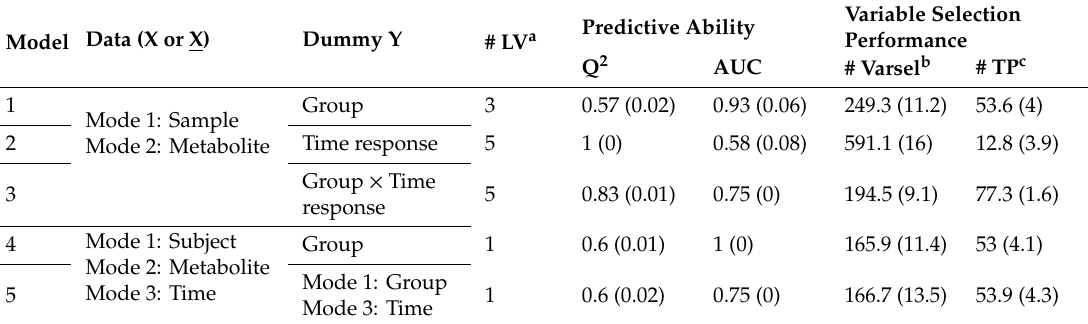
Table 2. Performance of five PLS models evaluated on simulated datasets with the optimal number of latent variables.